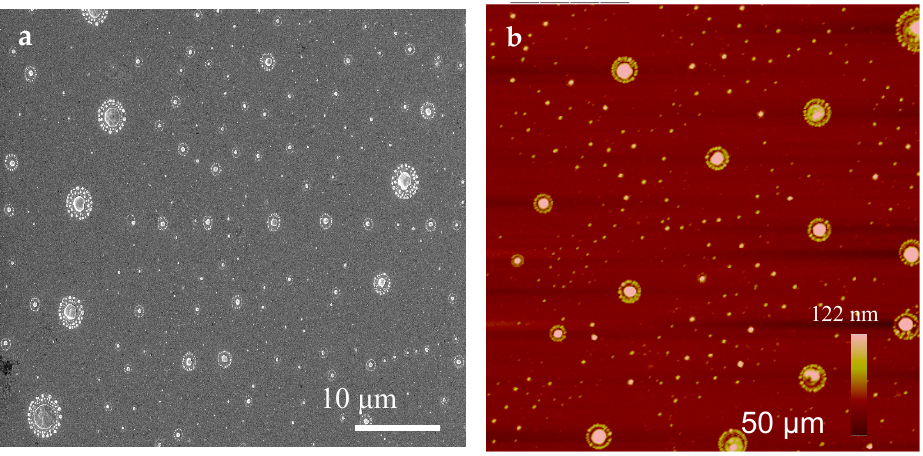
Figure 1. Protein self-assembly: ( a ) scanning electron microscopy (SEM) and ( b ) atomic force microscopy (AFM) images of discrete protein ring patterns.